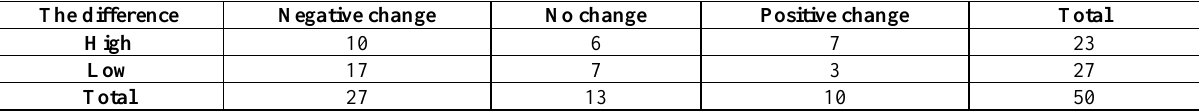
Table 5. The effect of digitalization on the revenue groups among the businesses surveyed.